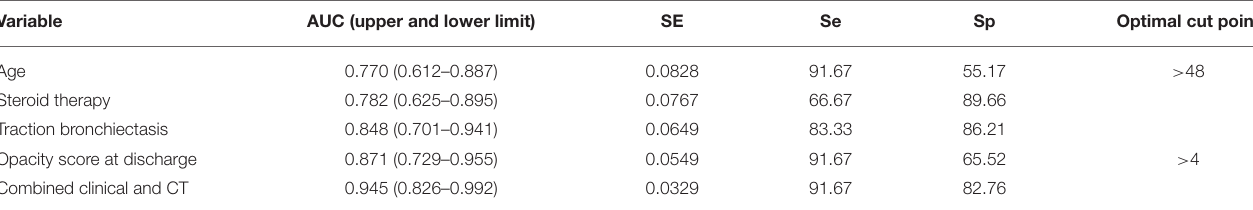
TABLE 4 | ROC analysis results for independent variables for predicting pulmonary fibrosis at 7 months after discharge.